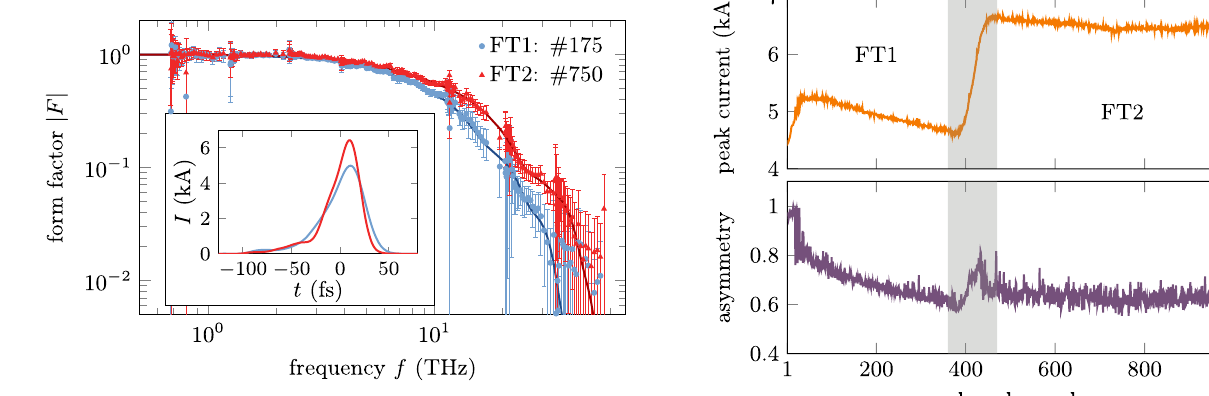
FIG. 13. Peak current and asymmetry of the current profiles along the bunch train during user XFEL operation with two rf